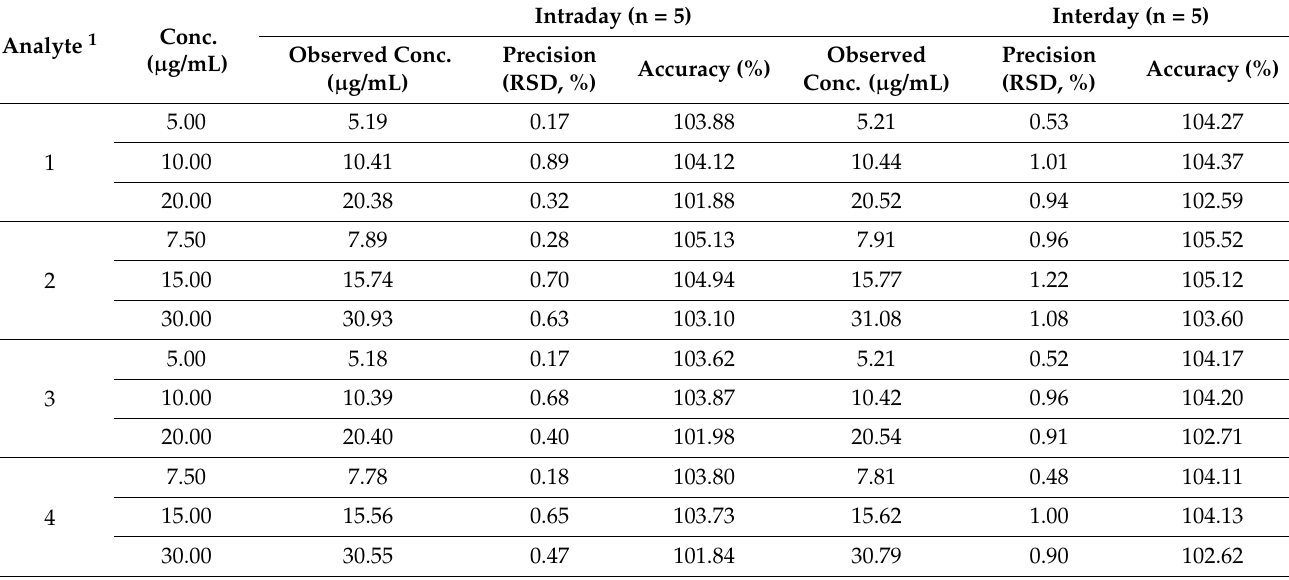
Table 4. Precision test of target compounds 1 – 7 in the developed HPLC